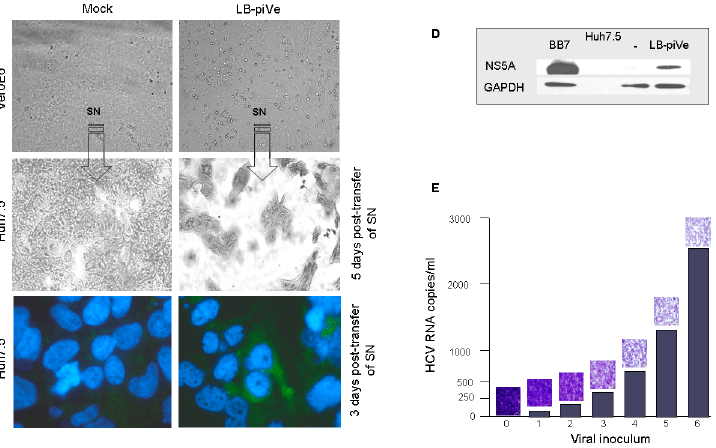
Figure 2. HCV growth can be measured by observing cytopathic effects. Light microscopy of (A) mock-infected VeroE6 ( left panel ) and LB-piVe cells ( right panel ) and (B) crystal violet-stained Huh7.5 cells 5 days after transfer of supernatant from A. (C) Mock-infected ( left panel ) and LB-piVe-infected Huh7.5 cells (from B, right panel ) immunostained with anti-Core antibodies at 3 dpi. (D) Immunoblot of BB7 replicon containing Huh7.5 cells or LB-piVe-infected Huh7.5 cell extracts, stained with anti-NS5A antibody. (E) Histogram showing quantitative RNA titer (HCV RNA copies/ml, see Materials and Methods for details on HCV RNA quantification) and corresponding micrographs of crystal violet stained LB-piVe-infected Huh7.5 cells at 5 dpi (mag 200 6 ).